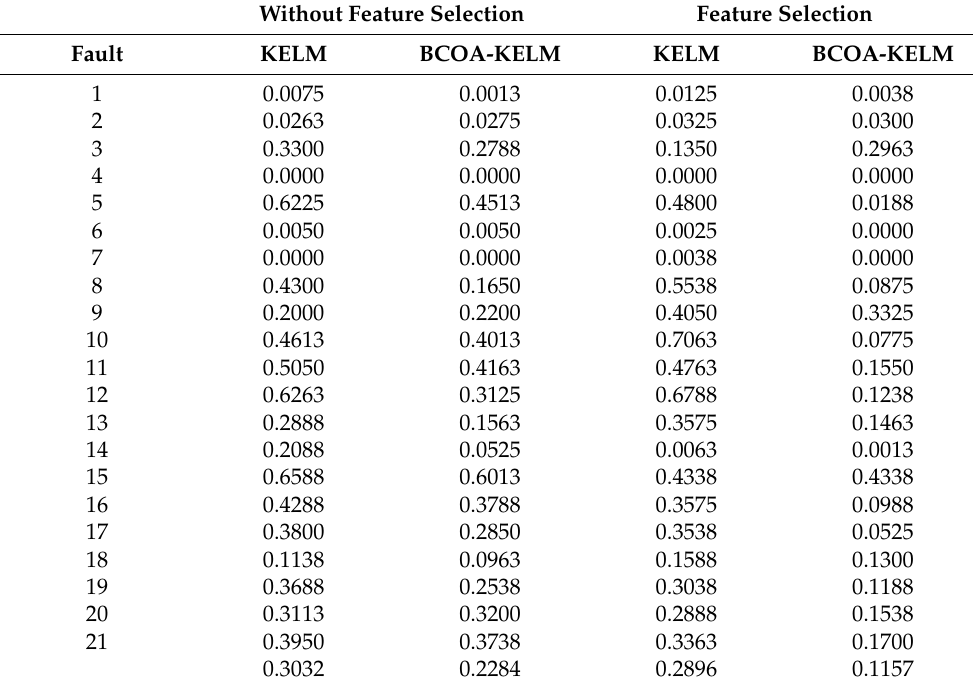
Table 9. FPR of the base algorithm and related improved